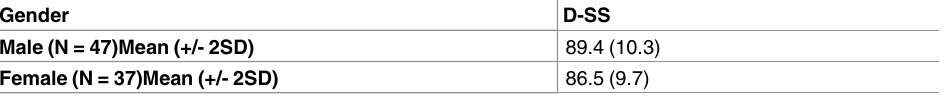
Table 4. Age adjusted normative values of distance between the ocular skin and the substantianigra (D-SS) stratified for gender.